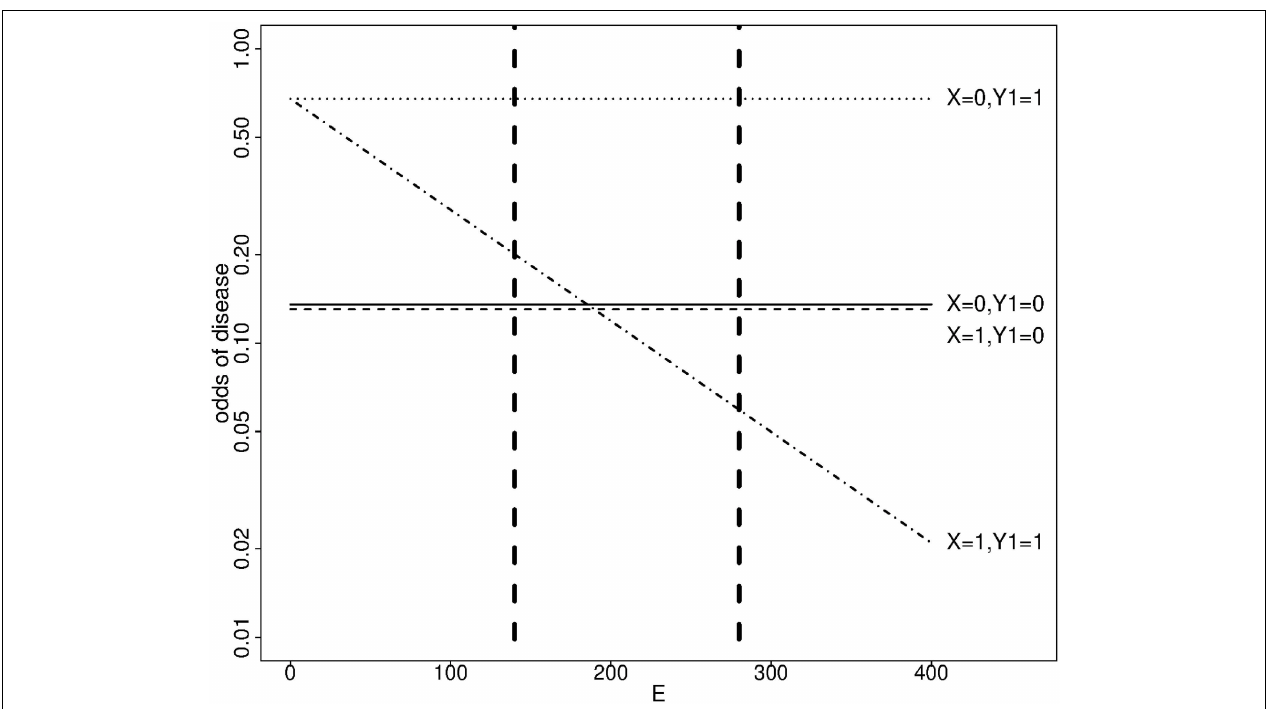
FIGURE 1 | Simulated odds of disease as a function of a genotype X and a continuous exposure E at age 40 under transition model 1. X: number of minor alleles. Y 1 = 1 if an endophenotype impairment is present, 0 otherwise. Dashed vertical lines show the first and third quartiles of